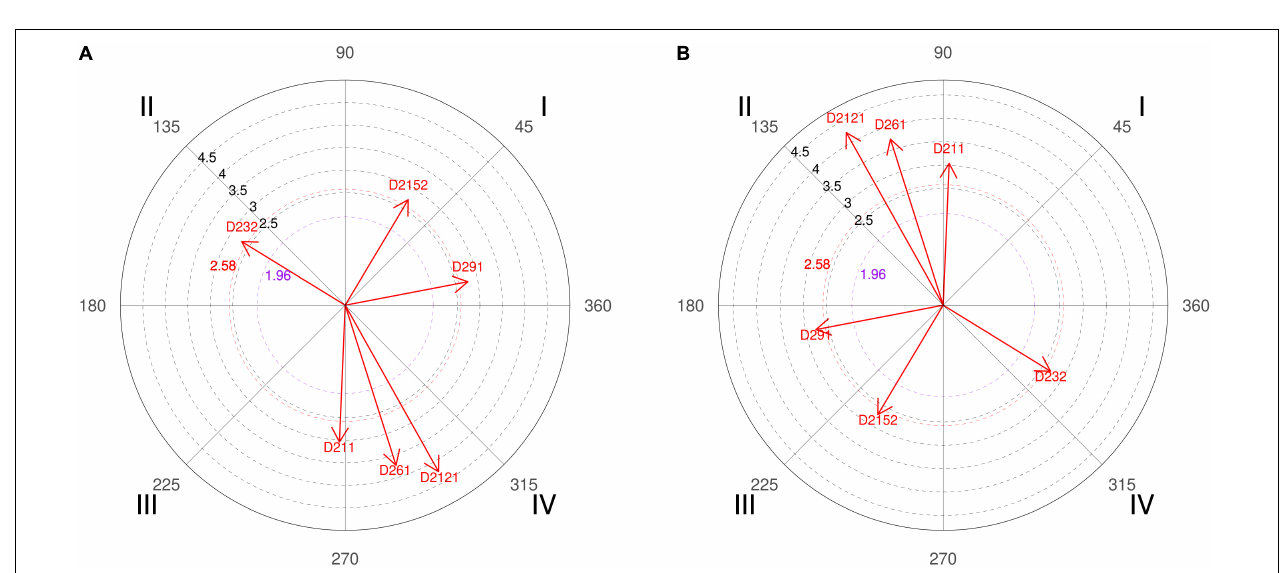
FIGURE 4 | (A,B) Relationship of conditioned behaviors that present a significant relationship with the focal behaviors “favorable evaluation” and “unfavorable evaluation” analyzing question 9 of the in-depth interviews. In “favorable evaluation,” a total of 15 significant vectors were detected, and in “unfavorable evaluation,” a total of 15 significant vectors were detected.